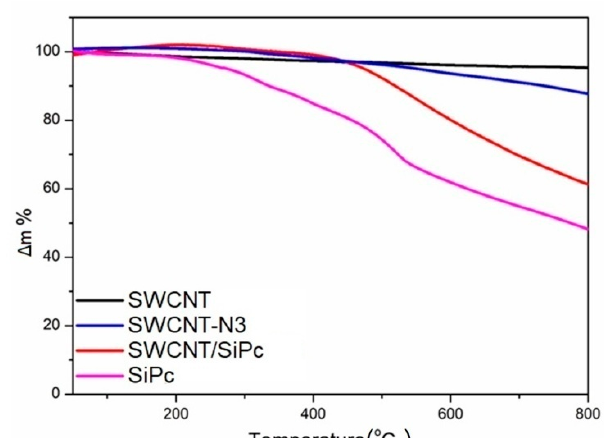
Figure 5. Thermogravimetric analysis of SWCNT/SiPc hybrid nanomaterial in comparison with pristine SWCNTs, SWCNT-N3 and SiPc.